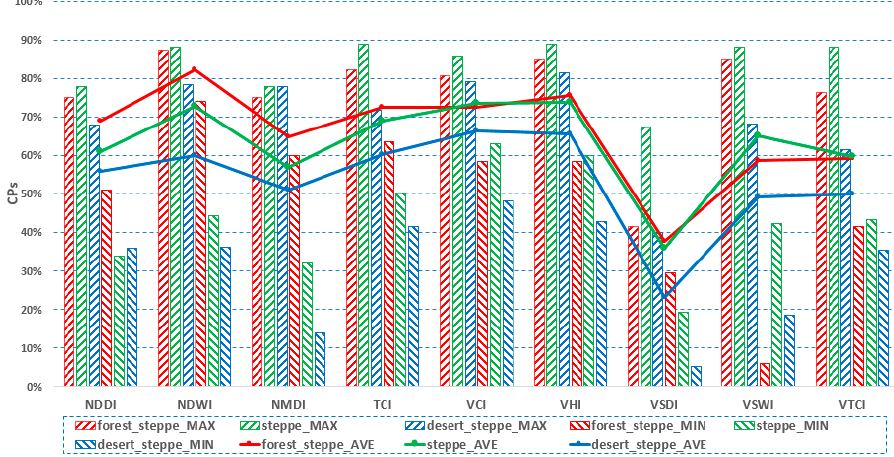
Figure 6. Maximum, minimum and average CPs for the three land-cover types (forest steppe, steppe, and desert steppe) across stations. indices TCI, VCI, VHI, NDWI, NMDI, NDDI, VSDI, VSWI, and VTCI as well as the RDA in three land-cover